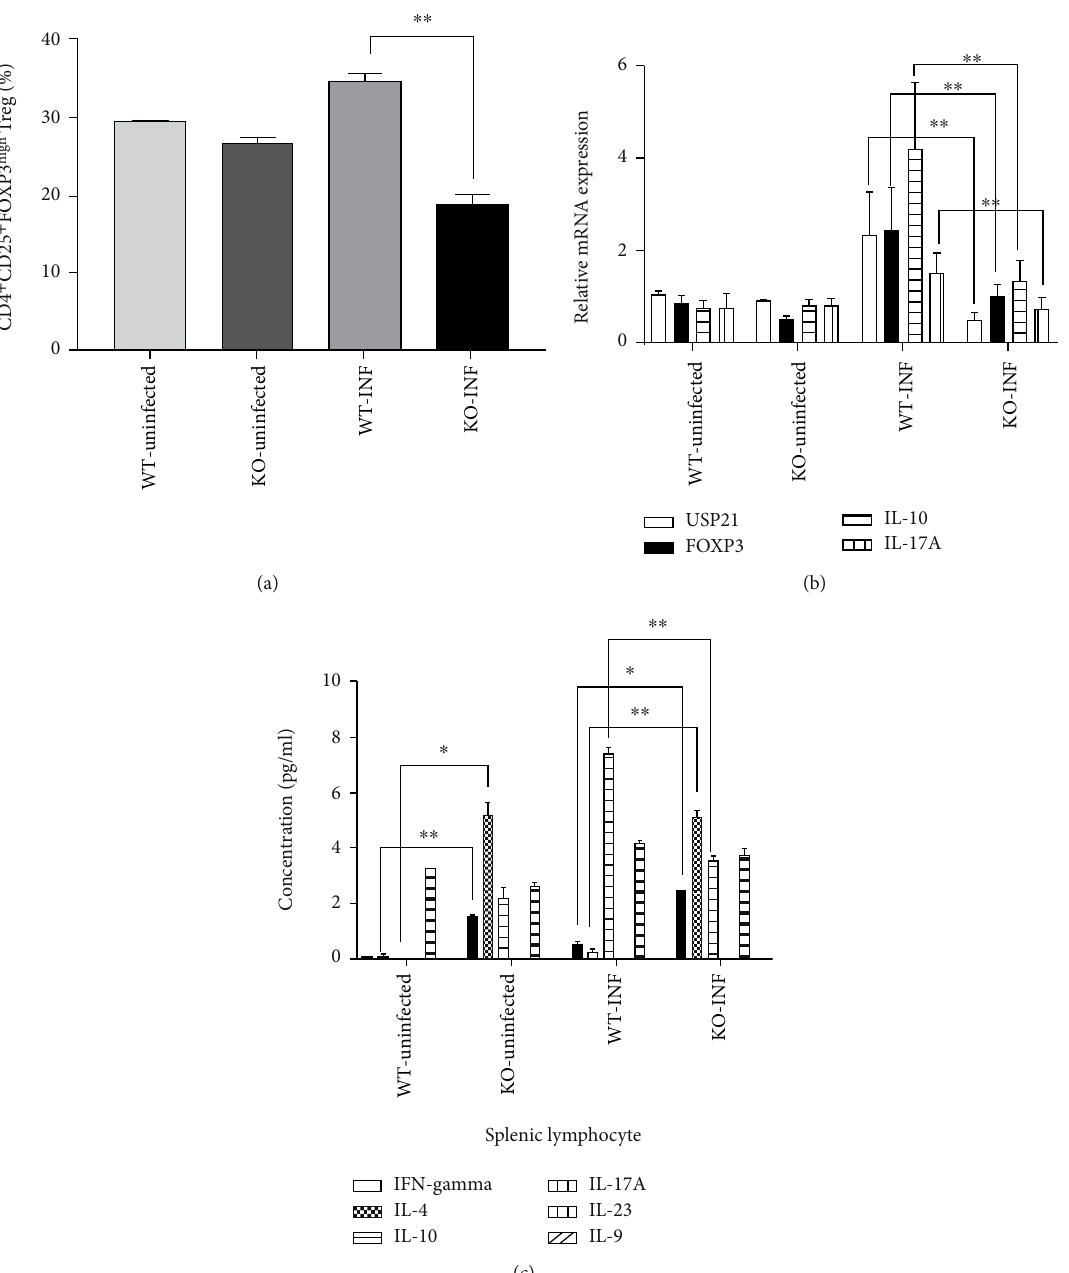
Figure 5: Changes in splenic immunity in USP21 fl / fl FOXP3 cre mice infected with S. japonicum . (a – c) The spleens were harvested from the mice on the 42nd day after the infection. (a) CD4 + CD25 + FOXP3 high cells directly isolated from the spleens of WT and KO mice in the NC and INF groups were identi fi ed using fl ow cytometry at 42 days after the infection with S. japonicum . Comparison of the proportion of CD4 + CD25 + FOXP3 high cells among the CD4 + T cell population in the WT and KO mice in the NC and INF groups. The data are presented as the means ± SD, infection groups: ∗∗ p = 0 : 007 . (b) Comparison of the mRNA levels of FOXP3, IL-10, IL-17, and USP21 in the WT and KO mice in the NC and INF groups, and the data are presented as the means ± SD . For the comparison between the infection groups, FOXP3 ∗∗ p = 0 : 001 , IL-10 ∗∗ p < 0 : 001 , IL-17 ∗∗ p < 0 : 001 , and USP21 ∗∗ p < 0 : 001 . (c) The splenic cells were cultured in vitro ( n =